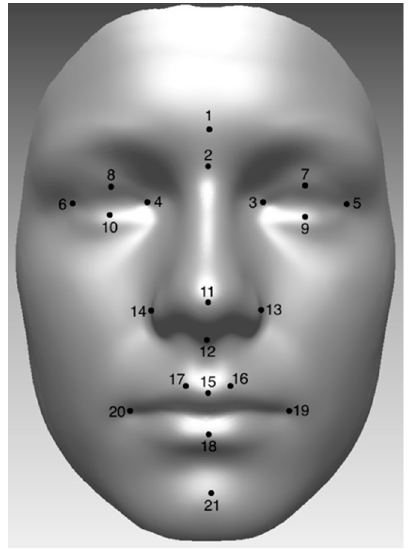
Figure 1. The 21 landmarks as described by Farkas [32]: (1) Glabella, (2) Nasion, (3) Endocanthion (Left), (4) Endocanthion (Right), (5) Exocanthion (Left), (6) Exocanthion (Right), (7) Palpebrale Superius (Left), (8) Palpebrale Superius (Right), (9) Palpebrale Inferius (Left), (10) Palpebrale Inferius (Right), (11) Pronasale, (12) Subnasale, (13) Alare (Left), (14) Alare (Right), (15) Labiale Superius, (16) Crista Phitri (Left), (17) Crista Philtri (Right), (18) Labiale Inferius, (19) Cheilion (Left), (20) Cheilion (Right), and (21) Pogonion.